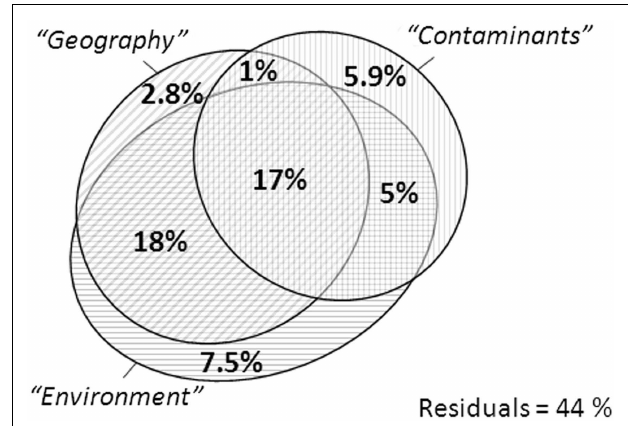
FIGURE 3 |Variance partitioning on the first axis of the above mentioned FPCA carried out on 84 samples and corrected for “ Methodology .” “ Geography ,” “ Environment ” and “ Contaminants ” groups of explanatory variables include only those variables which showed a significant effect in Table 1